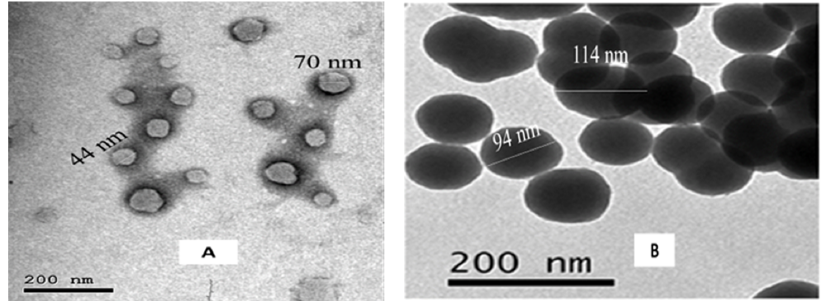
Figure 3. ( A ). TEM image of BSA-NPs. ( B ). TEM image of CA-BSA-NPs.